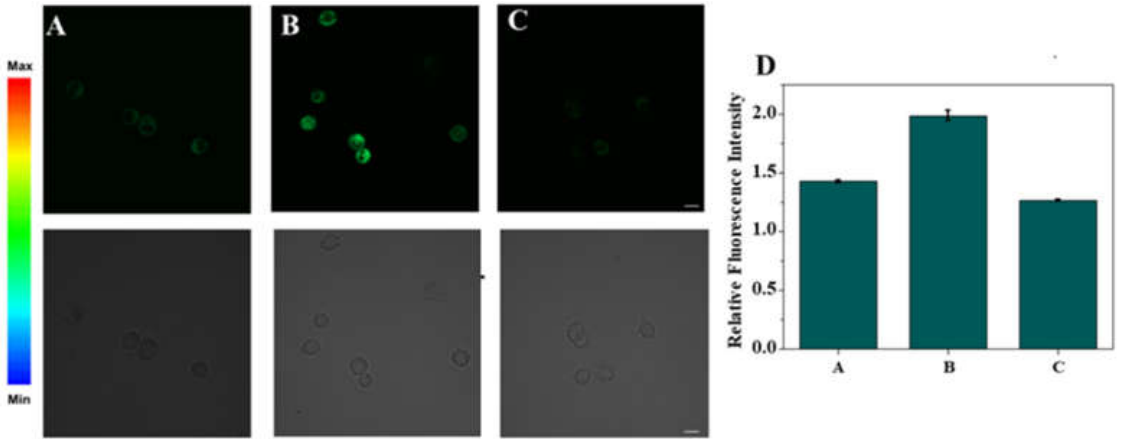
Figure 4. Fluorescence imaging of ONOO − in RAW 264.7 cells treated with ( A ) probe only, ( B ) 1.2 µ g mL − 1 LPS 16 h, 70 ng mL − 1 IFN- γ 4 h, and ( C ) LPS, IFN- γ + 150 µ M ebselen. ( D ) Relative fluorescence intensity of ( A – C ). Cells were stained with HDBT-ONOO − (10 µ M) for 30 min, washed with PBS, and imaged by confocal microscopy. λ ex = 880 nm, scale bar: 30 µ m. Error bars represent the standard deviations of three separate measurements (n = 3).